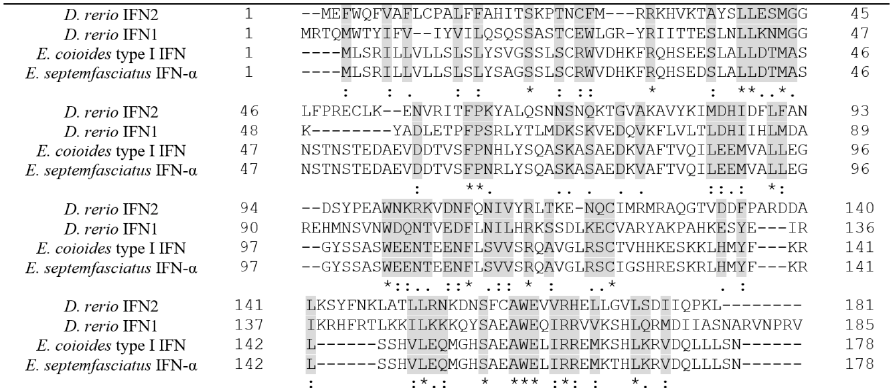
Figure 1. Multiple alignment of the interferons from Danio and Epinephelus . Multiple alignment of amino